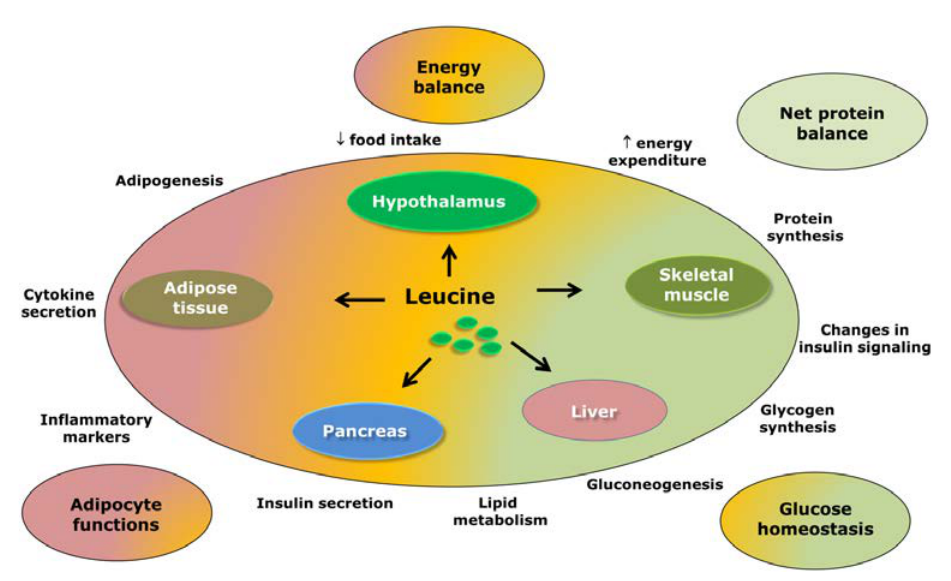
Figure 4. Possible effects of leucine supplementation in the regulation of energy balance and glucose homeostasis. This scheme summarizes the available evidence regarding the likely effects of leucine supplementation in different tissues and its subsequent